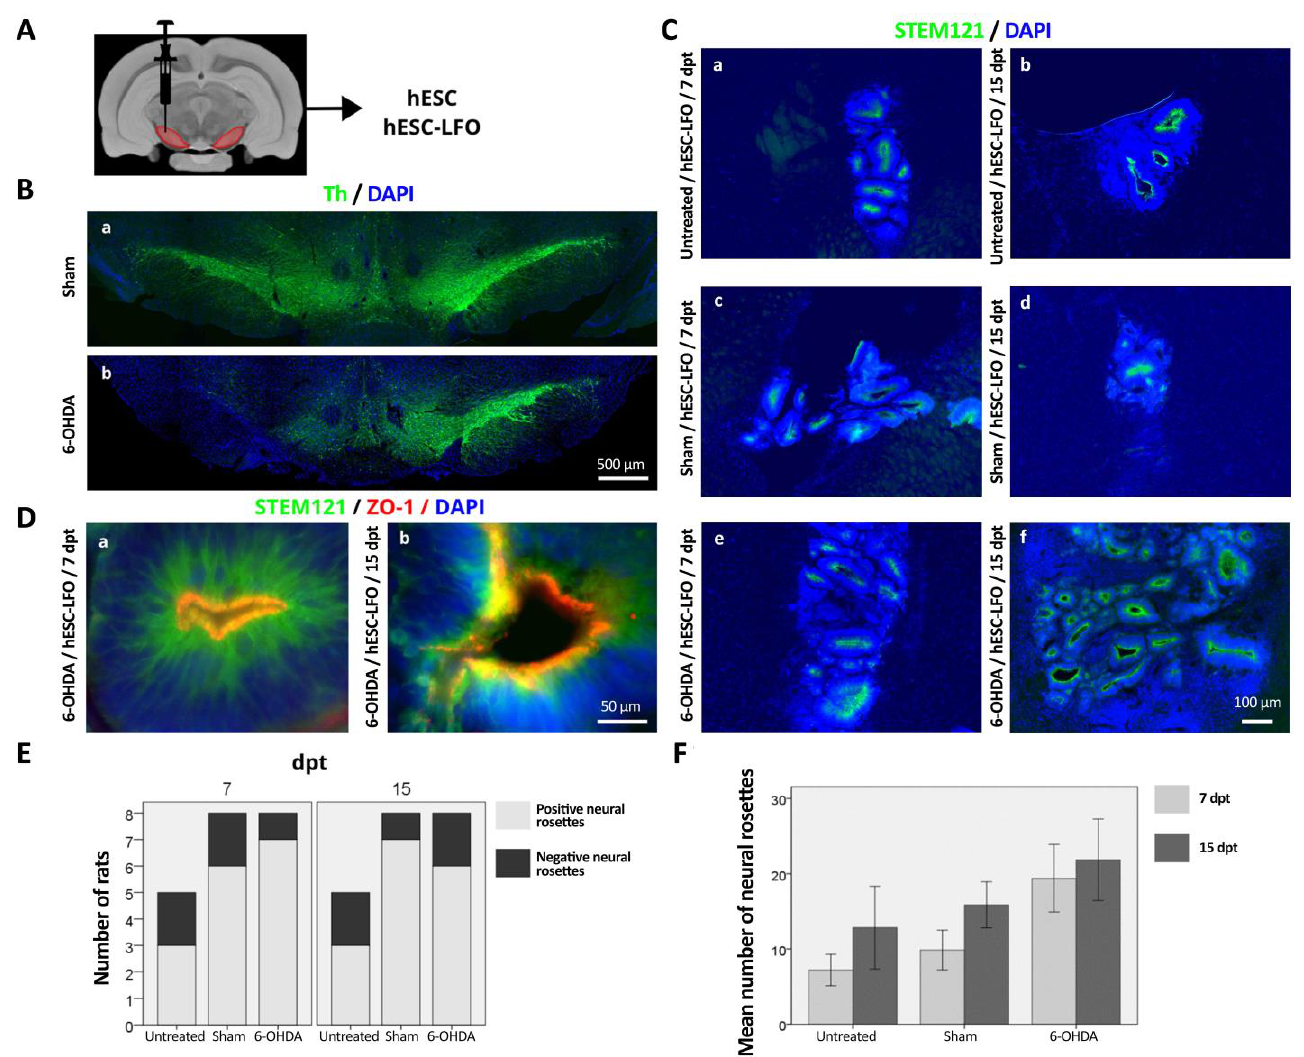
Figure 1. hESC-LFO EBCs differentiated into neural rosettes in the substantia nigra. ( A ) Schematic representation of EBCs transplantation protocol. EBCs from hESC and hESC-LFO cell lines were engrafted into SNpc, and at 7, 15, and 30 dpt brain tissue was analyzed. ( B ) Th expression in the SNpc of the ( a ) sham animals and the ( b ) 6-OHDA-lesioned rats 15 days after injury, at which time EBC engraftment takes place. ( C ) Representative photomicrographs of the neural rosettes found at ( a , c , e ) 7 and ( b , d , f ) 15 dpt in the SNpc of untreated ( a , b ), sham ( c , d ), and 6-OHDA-injured ( e , f ) rats. ( D ) Neural rosettes in the lesioned SNpc with STEM121 expression in green, and ZO-1 protein in red, expressed in the lumen of neural rosettes at ( a ) 7 and ( b ) 15 dpt. ( E ) Number of rats with grafts exhibiting neural rosettes (positive) or no neural rosettes (negative) according to the STEM121 human marker found in hESC-LFO transplants at 7 and 15 dpt on untreated ( n = 5), sham ( n = 8), and 6-OHDA ( n = 8) conditions. ( F ) Mean number of neural rosettes present in untreated, sham, and 6-OHDA groups at 7 and 15 dpt. dpt: days post-transplantation; Th: tyrosine hydroxylase; ZO-1: zonula occludens 1.